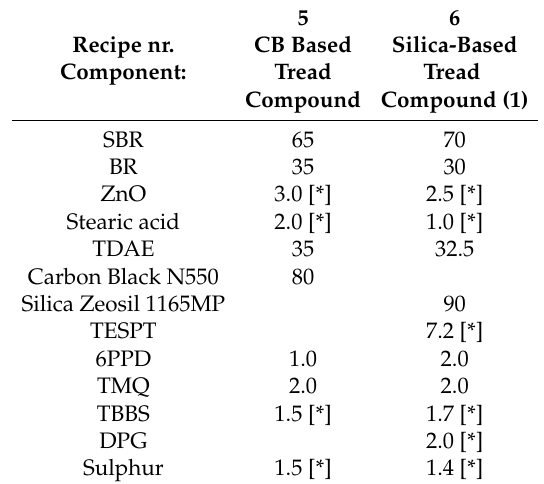
Table 8. Vulcanization formulations of tread compounds, values in